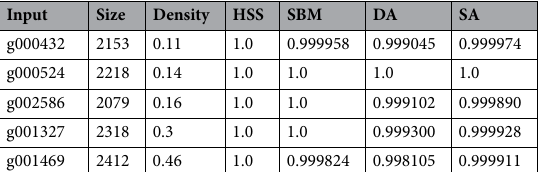
Table 2. Results for small and medium classes, same as Table 1.